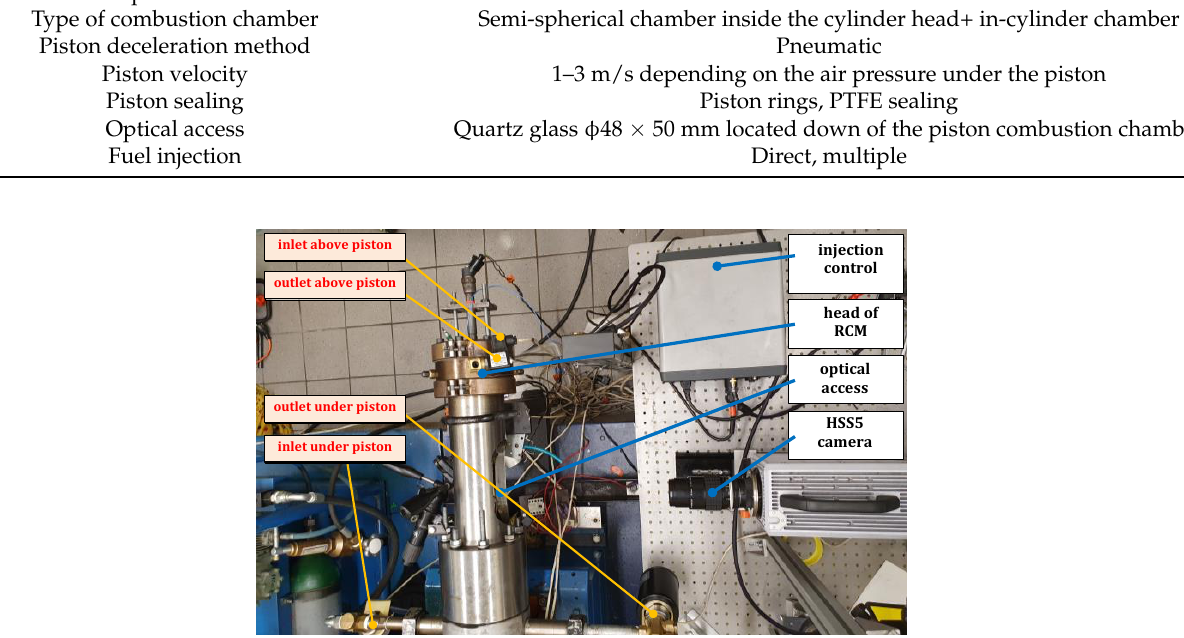
Figure 3. The RCEM and its components.